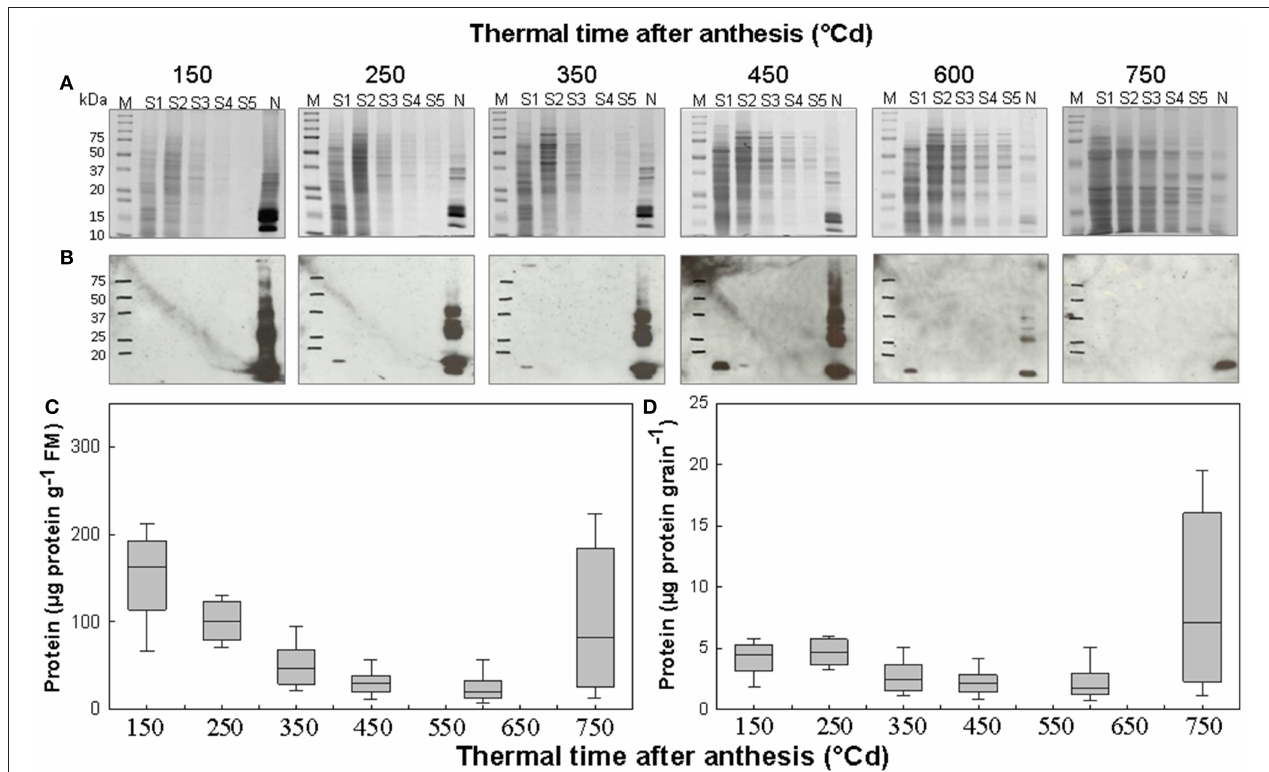
FIGURE 1 | Nuclear proteins extracted from developing wheat grains. Proteins from supernatants (S1–S5) and nuclear-enriched fractions (N) for each thermal time after anthesis (150–750 ◦ Cd) were analyzed on SDS-PAGE (A) then western blot analysis was performed using antibody directed against histone H3 (B) . M, molecular weight protein standards. Amount of proteins in the nuclear-enriched fraction per fresh mass (FM) of grain (C) or per grain (D) vs. thermal time after anthesis. In (C,D) boxes show the 25th to 75th percentile range, horizontal lines in boxes show medians, and error bars outside boxes show the 10th to 90th percentile range for n ≥ 10 independent